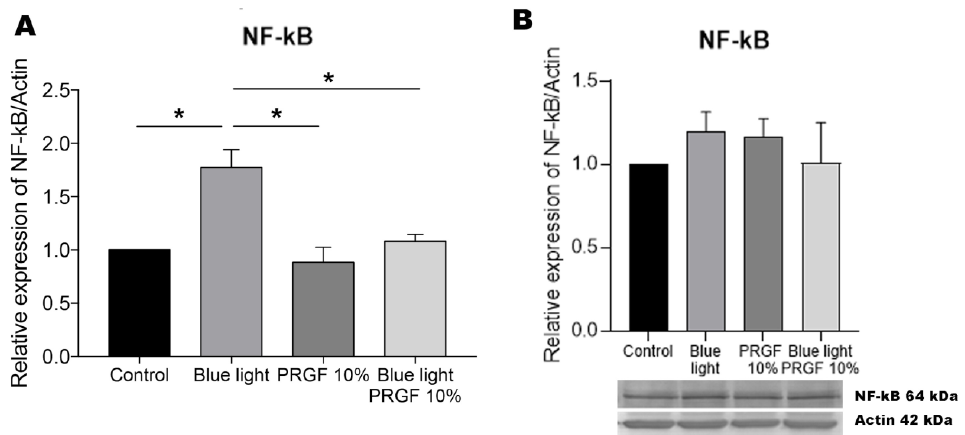
Figure 2. NF-kB gene expression and protein expression relative to the expression of actin. ( A ) NF-kB gene expression measured by qPCR. Results indicate that in response to blue light its gene expression was significantly increased. PRGF plus blue light treatment produced a significantly different effect to blue light alone, suggesting that PRGF was able to reduce the impacts of ROS. One-way ANOVA, Tukey’s multiple comparisons test, * p < 0.05 ( n = 4). ( B ) NF-kB protein expression measured by Western blotting. Results indicate no significant differences in protein expression among the treatments. One-way ANOVA, Kruskal–Wallis multiple comparisons test ( n = 4).